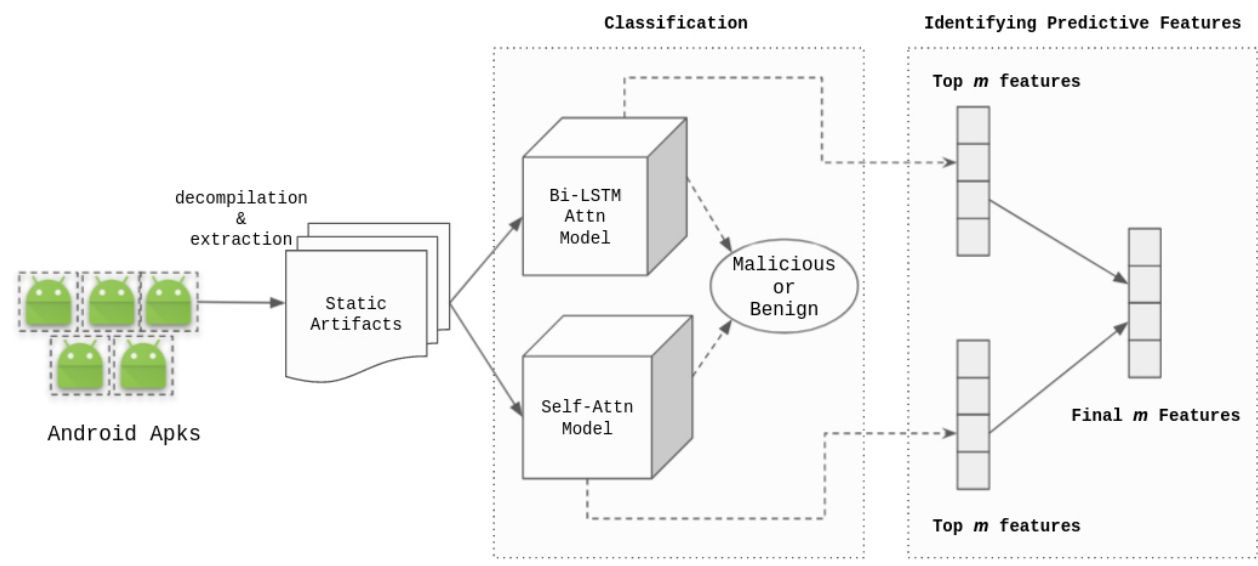
Figure 1. System design of attention-based security vetting of Android